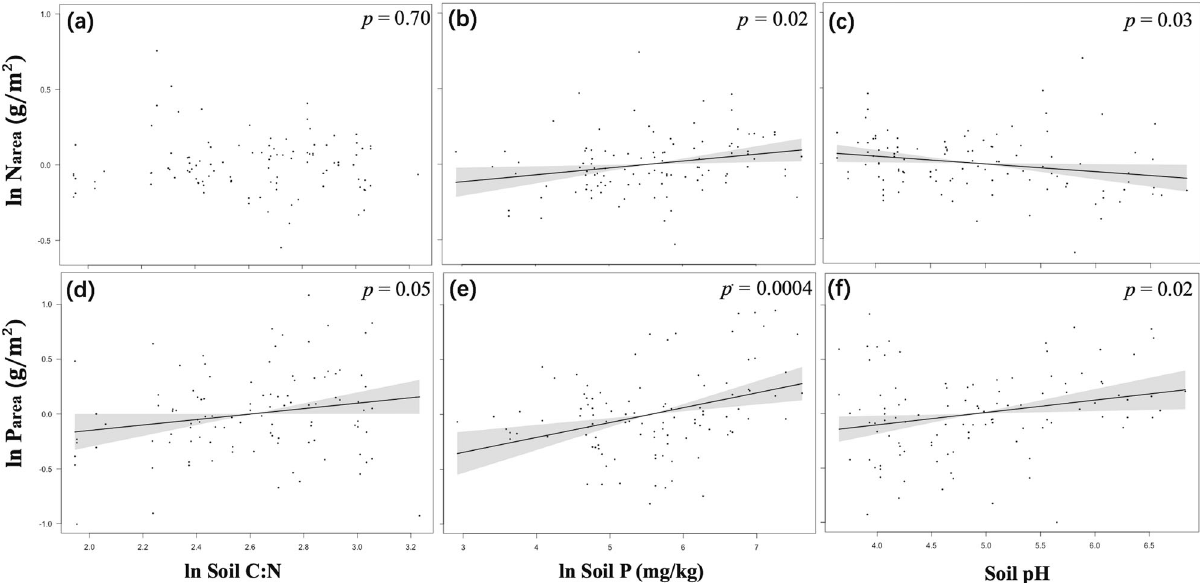
Fig. 4 Partial residual plots for leaf nutrients in relation to in situ measured soil properties. Partial residual plots for leaf nutrients (site means) in relation to in situ measured soil properties, for Narea ( a , b , c ) and Parea ( d , e , f ) data. Analyses for all species are shown in Fig. S1. Coef fi cients and standard errors for the fi tted lines are given in Supporting Information Table